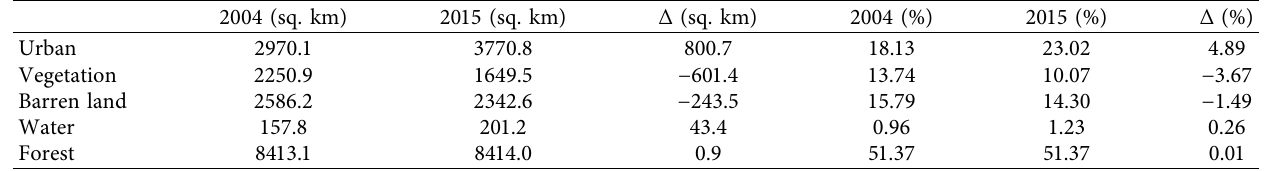
Table 5: A real change of LULC categories in different time spans between 2004 and 2015.